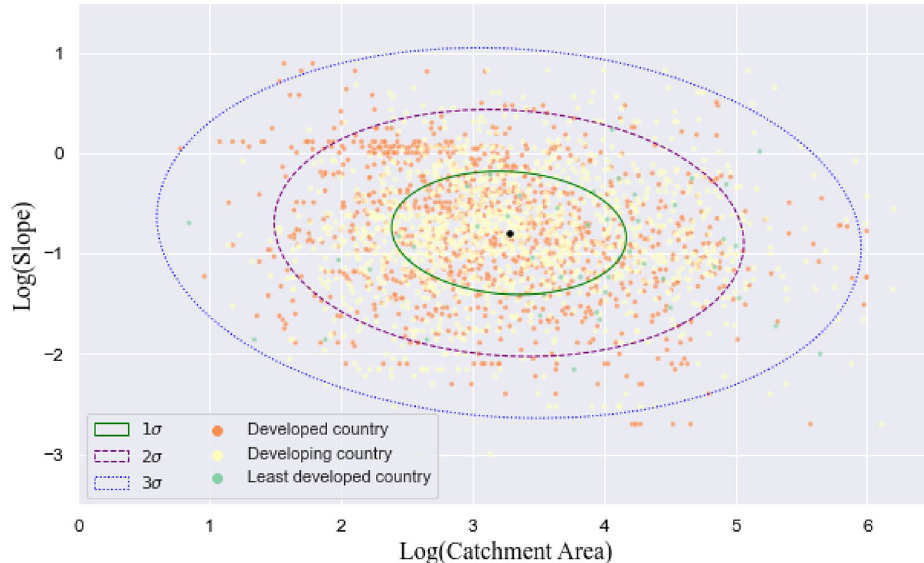
Fig. 5 Scatter diagram of all the large dams classified by the development level of the located